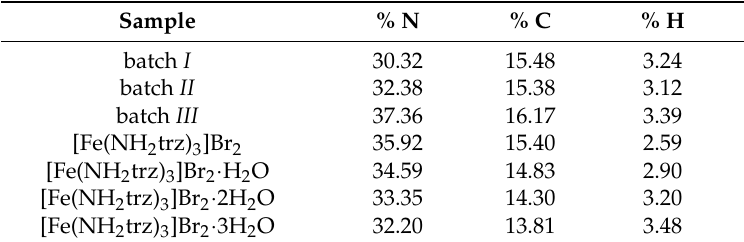
Table 1. Elemental analysis (CHN) for batches I , II , and III , including the expected values